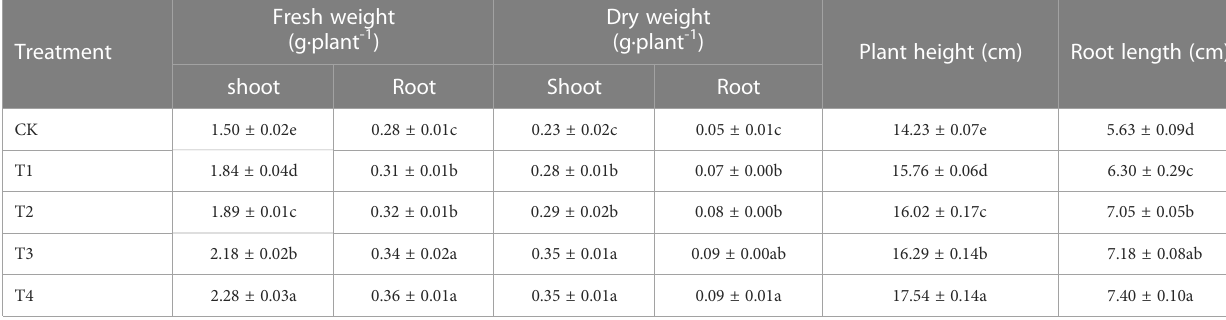
TABLE 2 Effect of different Si treatments on weight, height and root length of S. alfredii .